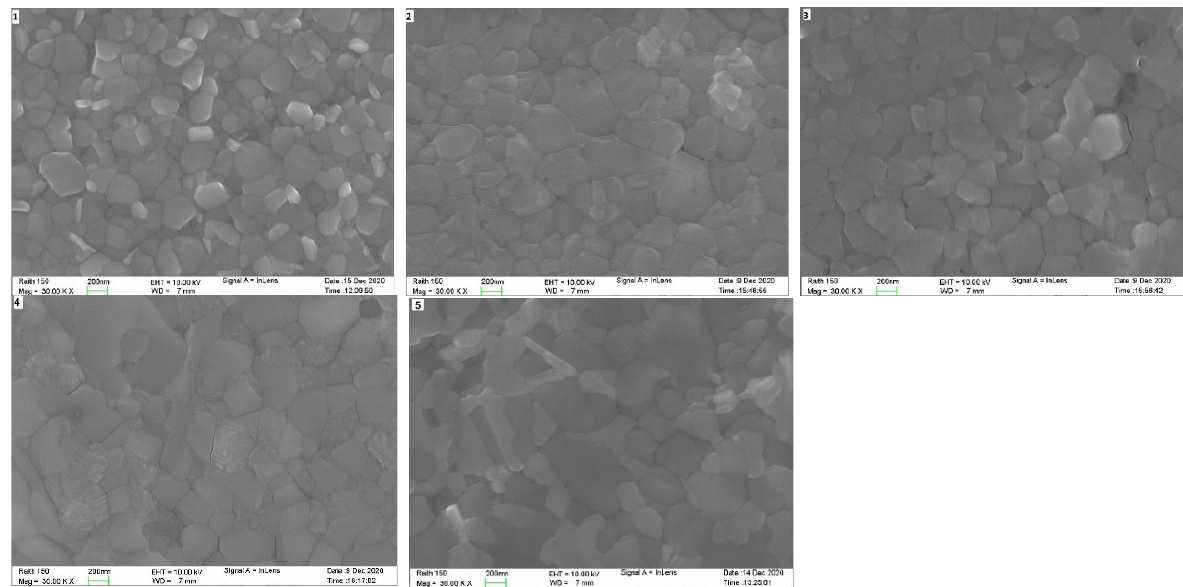
Figure 9. SEM images of the perovskite active layers prepared with different compositions for the 5 samples as detailed in Table 1 and are numbered accordingly.